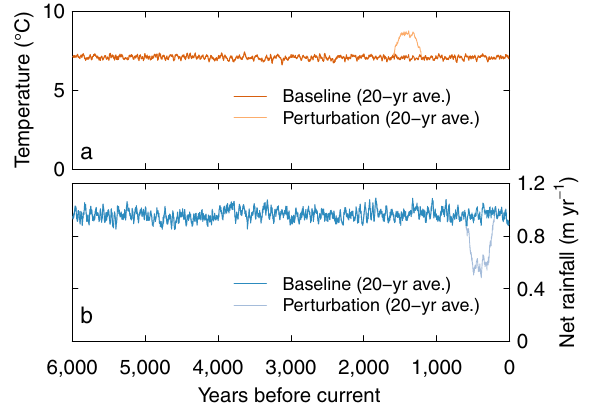
Figure 7. Modifications to the driving data for the simulations shown in Fig. 6. ( a ) Temperature and ( b ) net rainfall. The perturbations show the timing and duration of the deviations from the baseline simulation inputs.